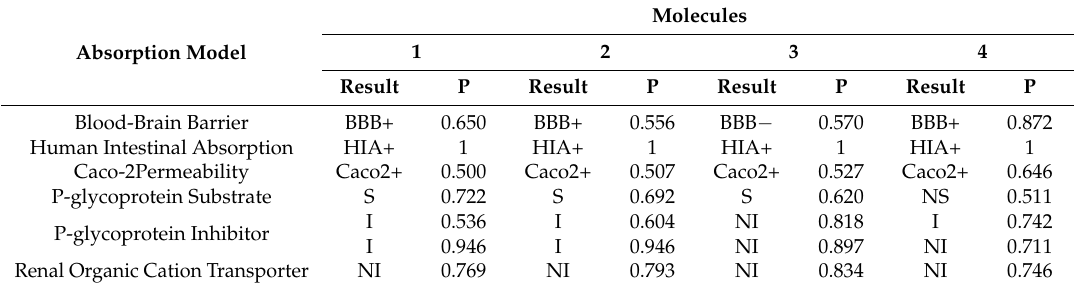
Table 4. Prediction of the absorption of the target molecules in different